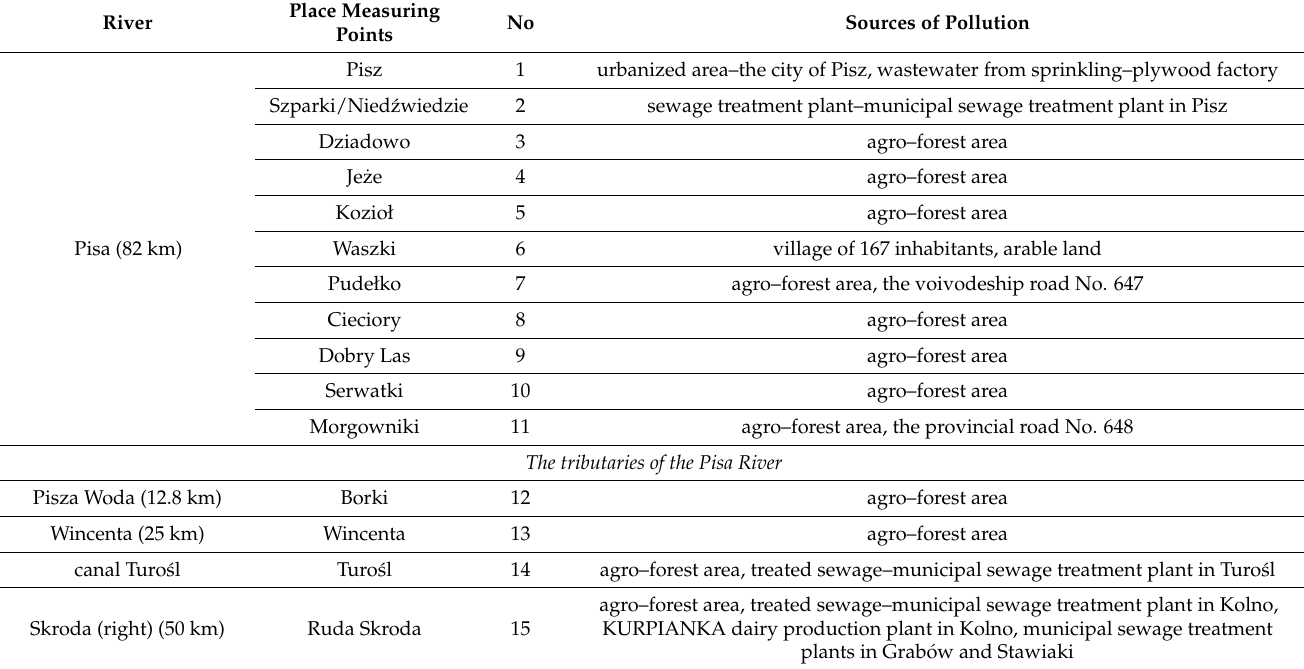
Table 1. Measurement points located on the Pisa River and its tributaries and sources of